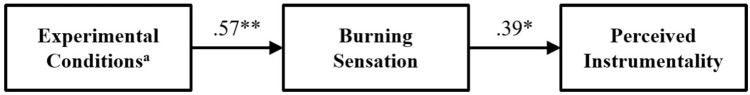
Results from the path analysis (Study 2). a0 = unifinal means; 1 = counterfinal means. ∗∗p < 0.001, ∗p < 0.05.